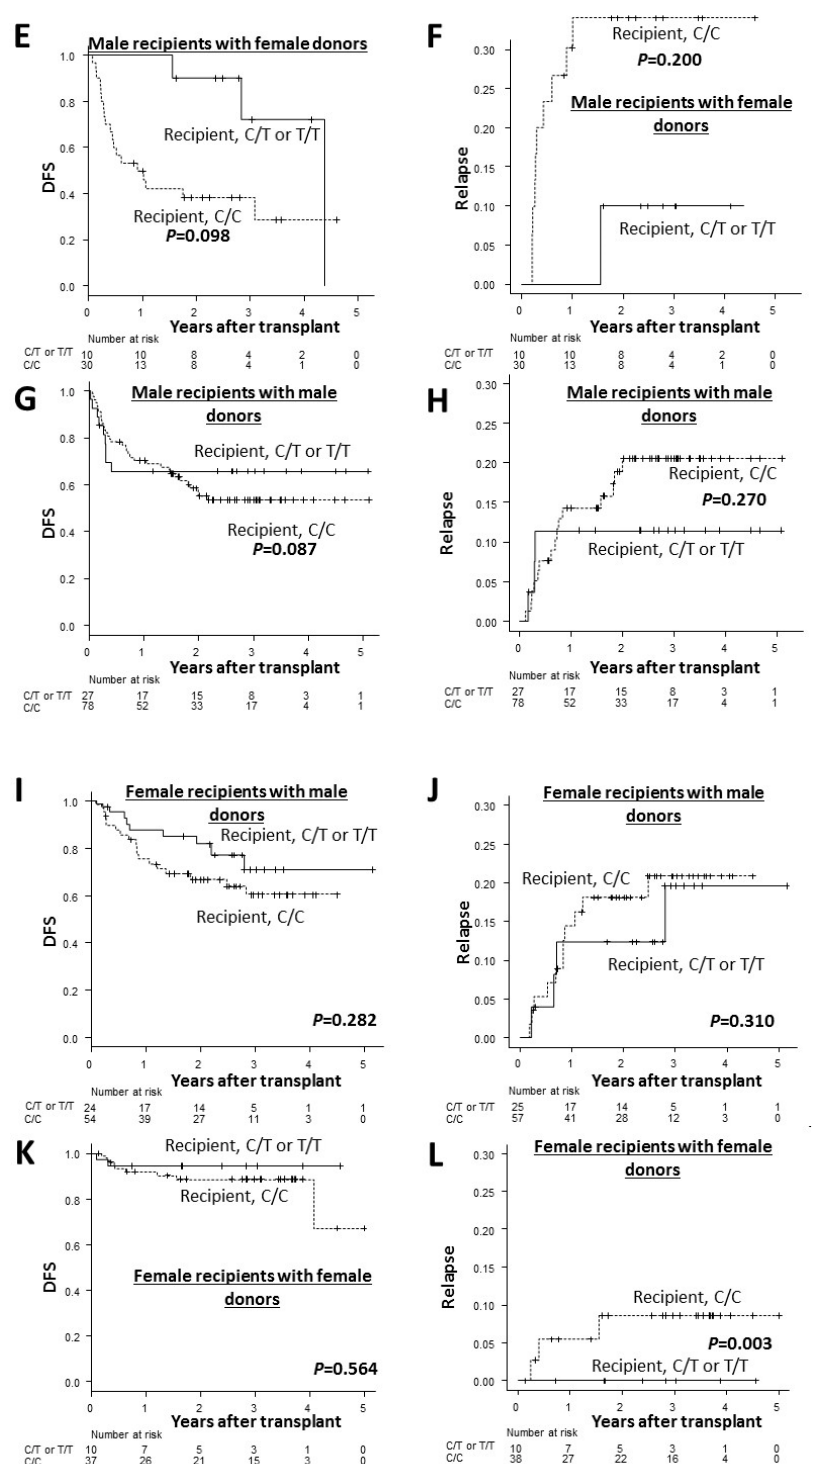
Figure 3. The Kaplan–Meier curves of the adjusted disease-free survival (DFS) rates ( A , C , E , G , I and K ) and the cumulative incidence curves of the adjusted relapse rates ( B , D , F , H , J and L ) after transplantation in male recipients ( A , B ), female recipients ( C , D ), male recipients with female donors ( E , F ), male recipients with male donors ( G , H ), female recipients with male donors ( I , J ) and female recipients with female donors ( K , L ) according to the recipient ADAMTS13 genotype. The solid lines represent the C/T or T/T genotype while the dashed lines represent the C/C